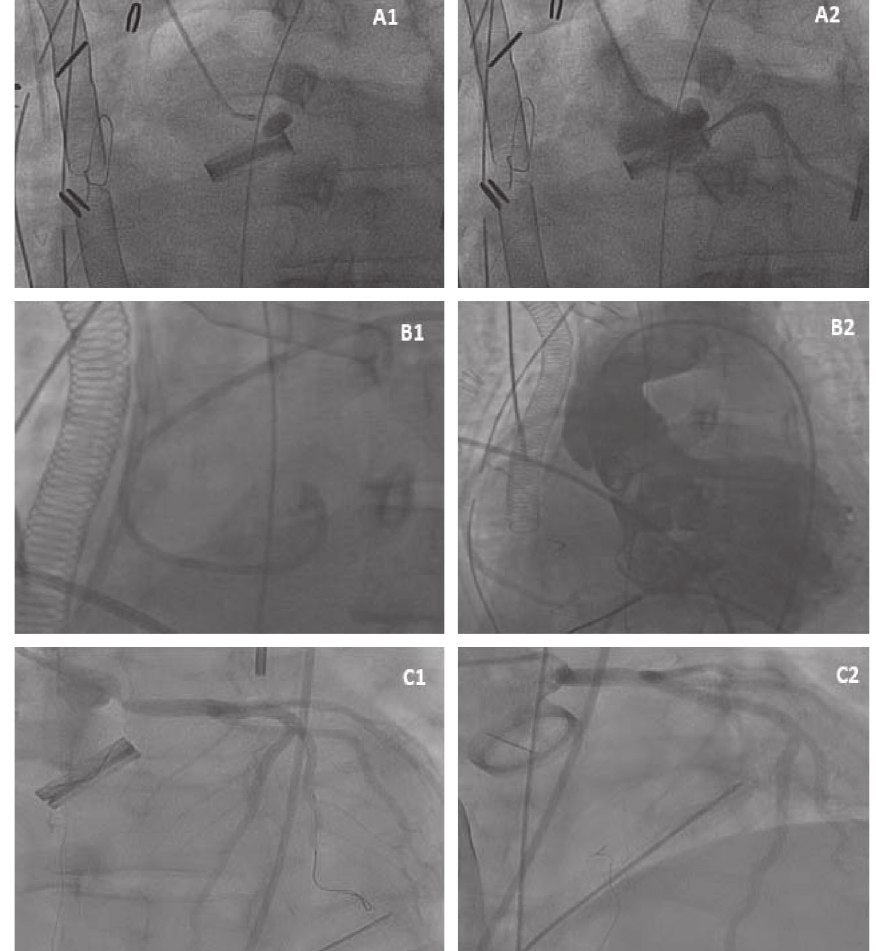
Figure 1: (a) Left main artery compression with mechanical valve and small dissection pouch at aortic root, and that case was referred to emergency CABG. (b) LM total occlusion after Bentall operation; aortogram showed the normal RCA and absent LM, emergency CABG. (c) LM critical stenosis after Bentall operation and successful LM